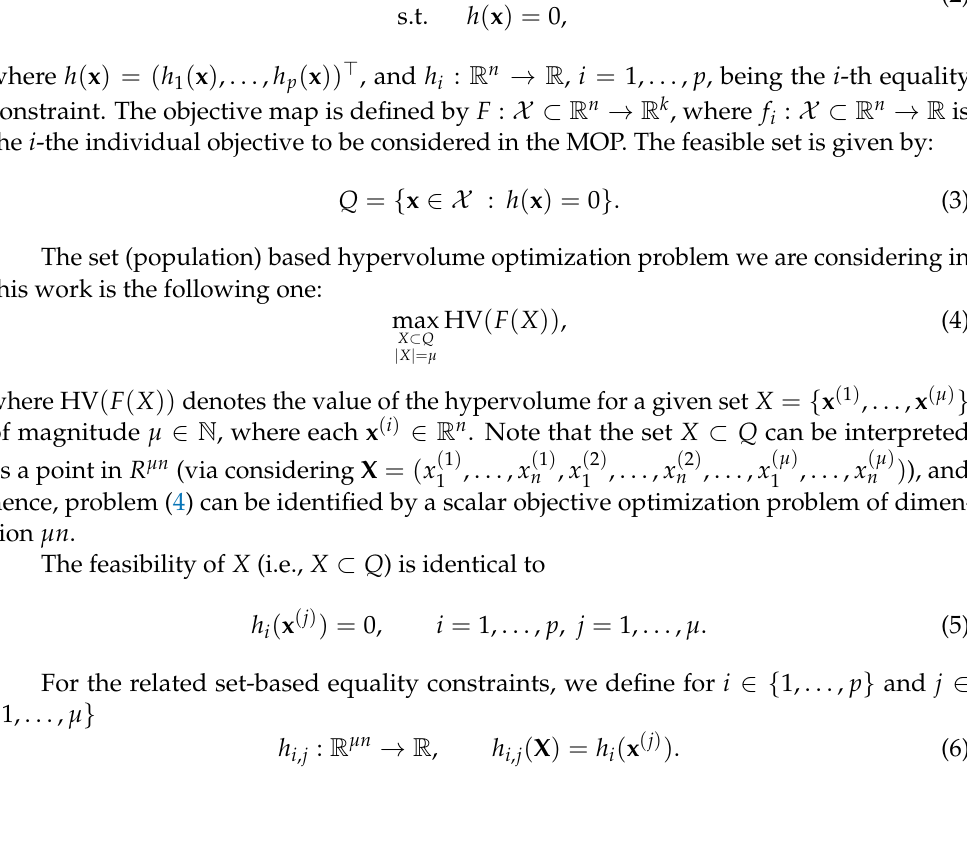
y ( 1 ) , y ( 2 ) , y ( 3 ) and reference point r { }